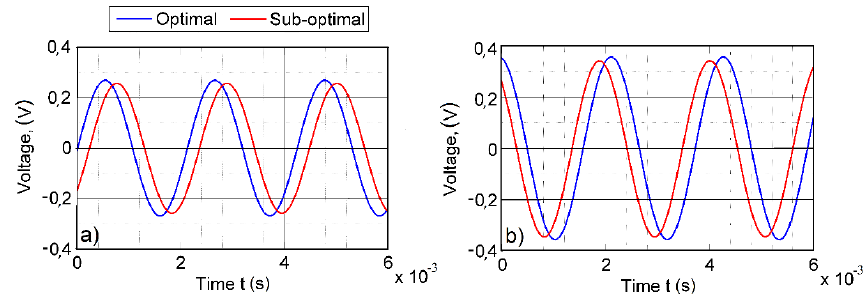
Figure 14. Open-circuit voltage output of the optimally-shaped cantilever at ω 2 = 545 Hz: ( a ) first segment; ( b ) second segment.